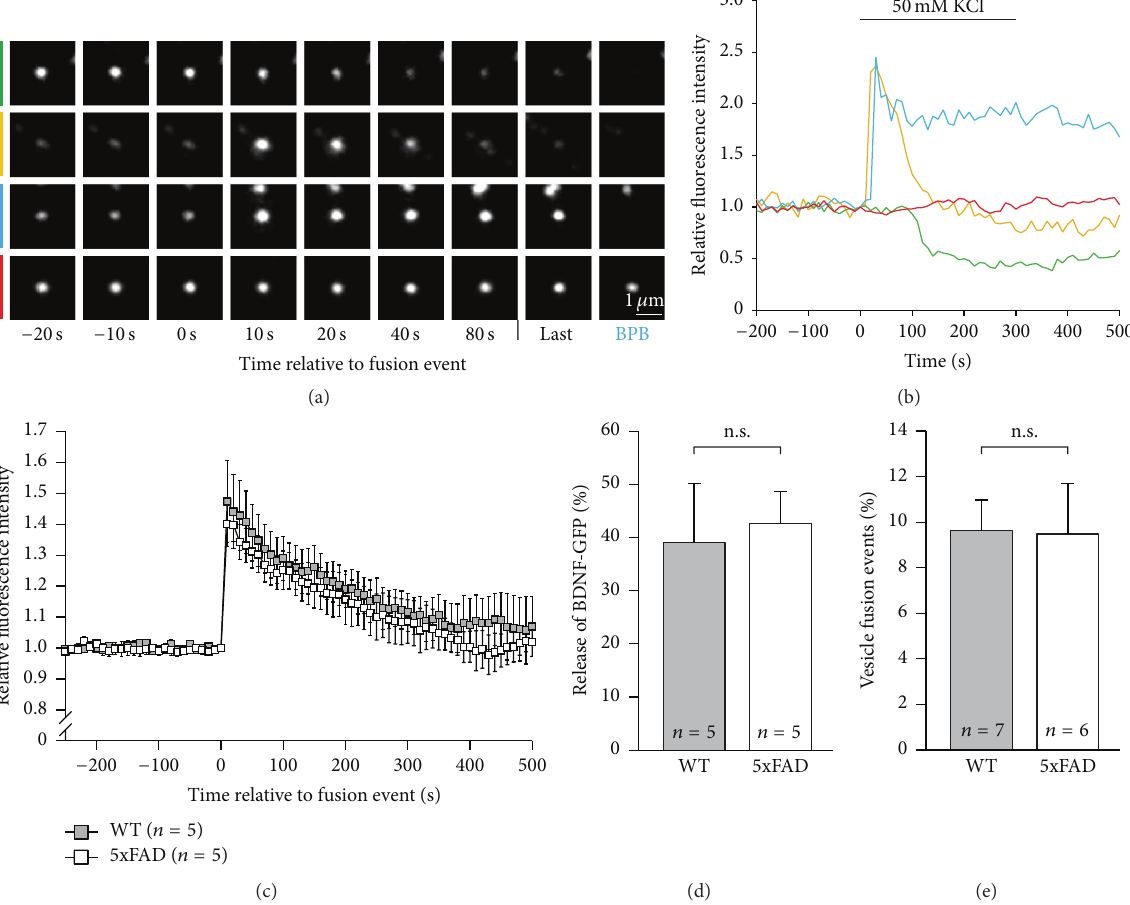
Figure 5: Release of BDNF was not affected after expression of mutated hAPP. Dissociated hippocampal neurons from 5xFAD mice and wild-type littermates, respectively, were transfected at 10 DIV with a BDNF-GFP plasmid. Depolarization-induced release of BDNF-GFP as well as the incidence of fusion event of BDNF-containing vesicles was analyzed by live cell imaging. (a) Representative single vesicles of a hippocampal neuron transfected with BDNF-GFP showing fusion events as indicated by the change in fluorescence intensity (green, yellow, and blue) compared to a single vesicle showing no fusion pore opening (red). For most events, BDNF-GFP fluorescence increased due to the neutralisation of the intragranular pH after fusion. BDNF release was observed as decrease in fluorescence intensity after fusion event. At the end of the release measurement, neurons were superfused with BPB (0.3mM) to differentiate between vesicles in an open or closed state at this time point (scale bar = 1 𝜇 m). (b) Graph shows time course of fluorescence intensity of color coded vesicles shown in (a). Change in fluorescence intensity indicates neutralisation of intravesicular pH after fusion pore opening of BDNF-GFP-containing vesicles (fluorescence increase) and depolarization-induced release of BDNF-GFP (fluorescence decrease), respectively. (c) Average time course of GFP-fluorescence intensity of single hippocampal neurons. Note the absence of any difference in release efficiency or time course between neurons from 5xFAD animals and wild-type littermates. (d) Quantification of the fluorescence decrease after fusion event. The maximal fluorescence intensity after fusion was set to 100% and the remaining fluorescence intensity 300 s after fusion pore opening was analyzed. BDNF release amplitude was unaltered in hippocampal neurons derived from 5xFAD mice. (e) Quantification of depolarization-induced fusion events. Bar diagram shows the percentage of fusion events of vesicles in hippocampal neurons from 5xFAD animals and wild-type littermates (n.s. = no significant difference; one-way ANOVA). Error bars represent